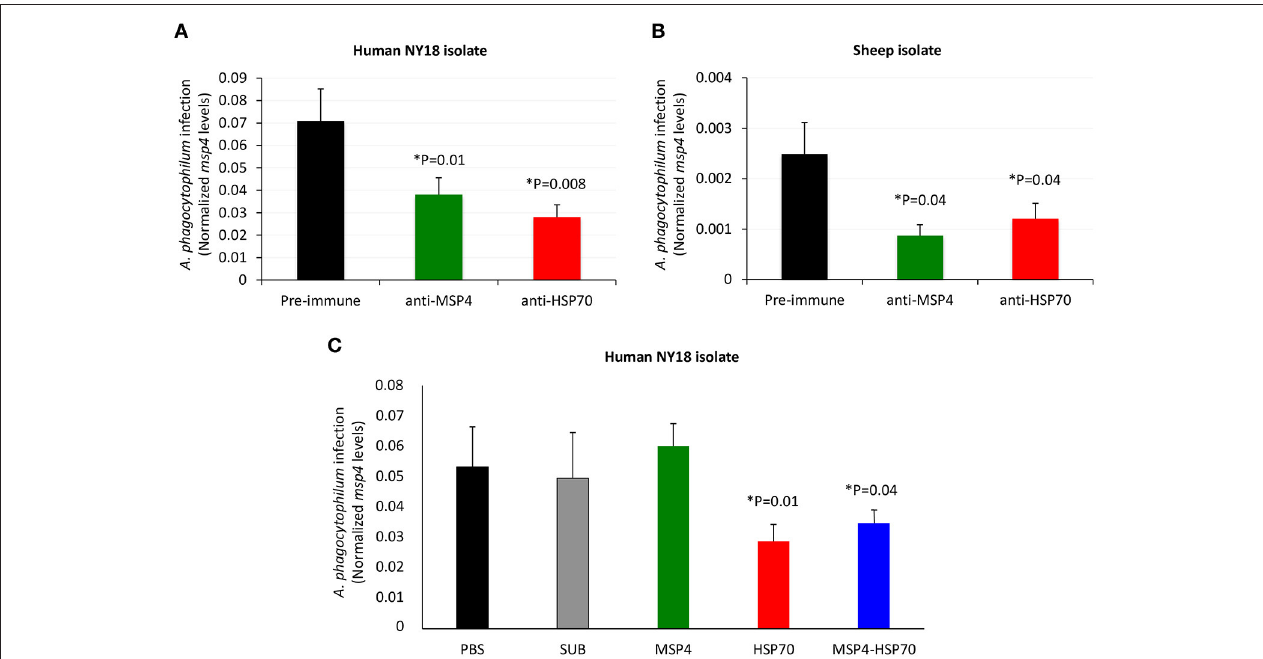
FIGURE 2 | Role of A. phagocytophilum MSP4 and HSP70 proteins in infection of HL60 human cells. (A,B) Rabbit antibodies against A. phagocytophilum MSP4 and HSP70 recombinant proteins or (C) MSP4, HSP70 and MSP4-HSP70 recombinant proteins were used to characterize the inhibition of pathogen infection of HL60 human cells. Rabbit purified IgGs or recombinant proteins were mixed with A. phagocytophilum inoculum of human NY18 or sheep isolates for 60 min before being placed on the cell monolayers. Treatments included rabbit pre-immune serum, PBS and SUB as negative controls. A. phagocytophilum infection levels were determined by msp4 real-time PCR normalizing against human β -actin . Results were compared between groups treated with pre-immune and anti-MSP4/HSP70 antibodies (A,B) or between groups treated with PBS or SUB and recombinant proteins (C) by the Student’s t -test with unequal variance (* P < 0.05; N = 4 replicates per